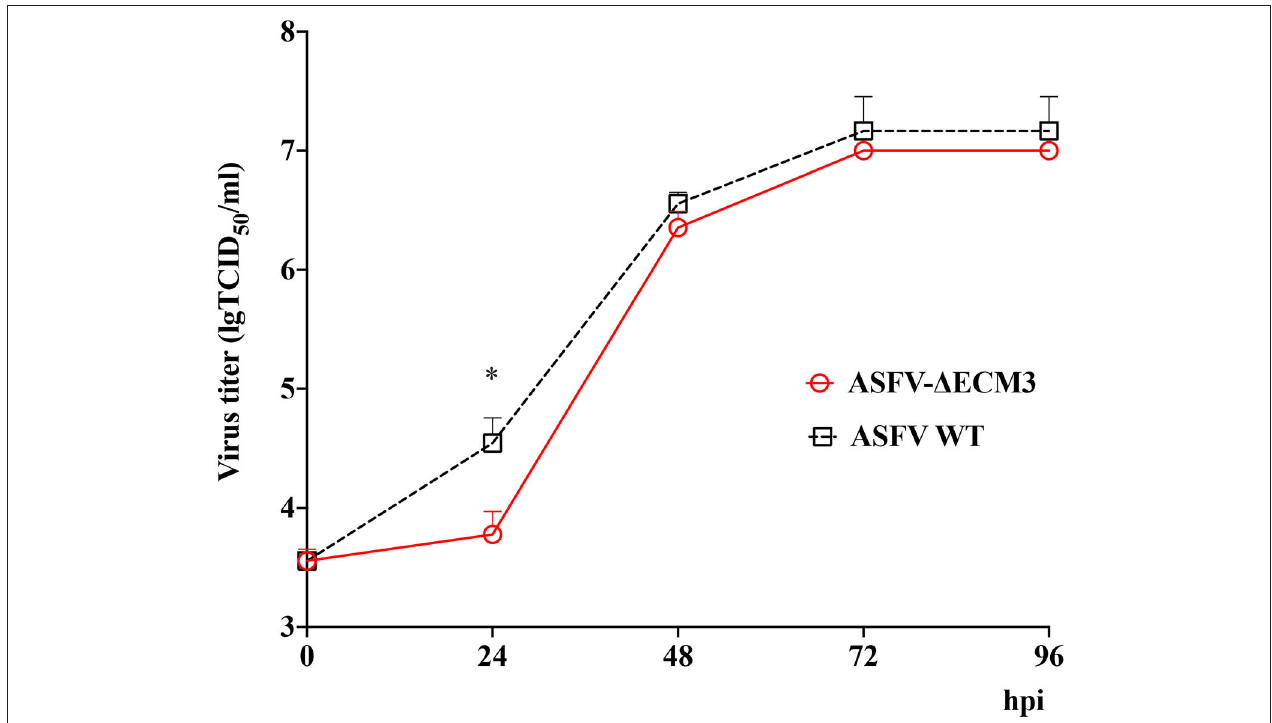
FIGURE 2 | In vitro growth characteristics of ASFV- 1 ECM3 and parental GZ201801 virus. Primary swine macrophage cell cultures were infected (MOI = 0.01) with either virus, and virus yield was titrated at the indicated times post-infection. Data represent means and SD from three independent experiments. * p < 0.05.